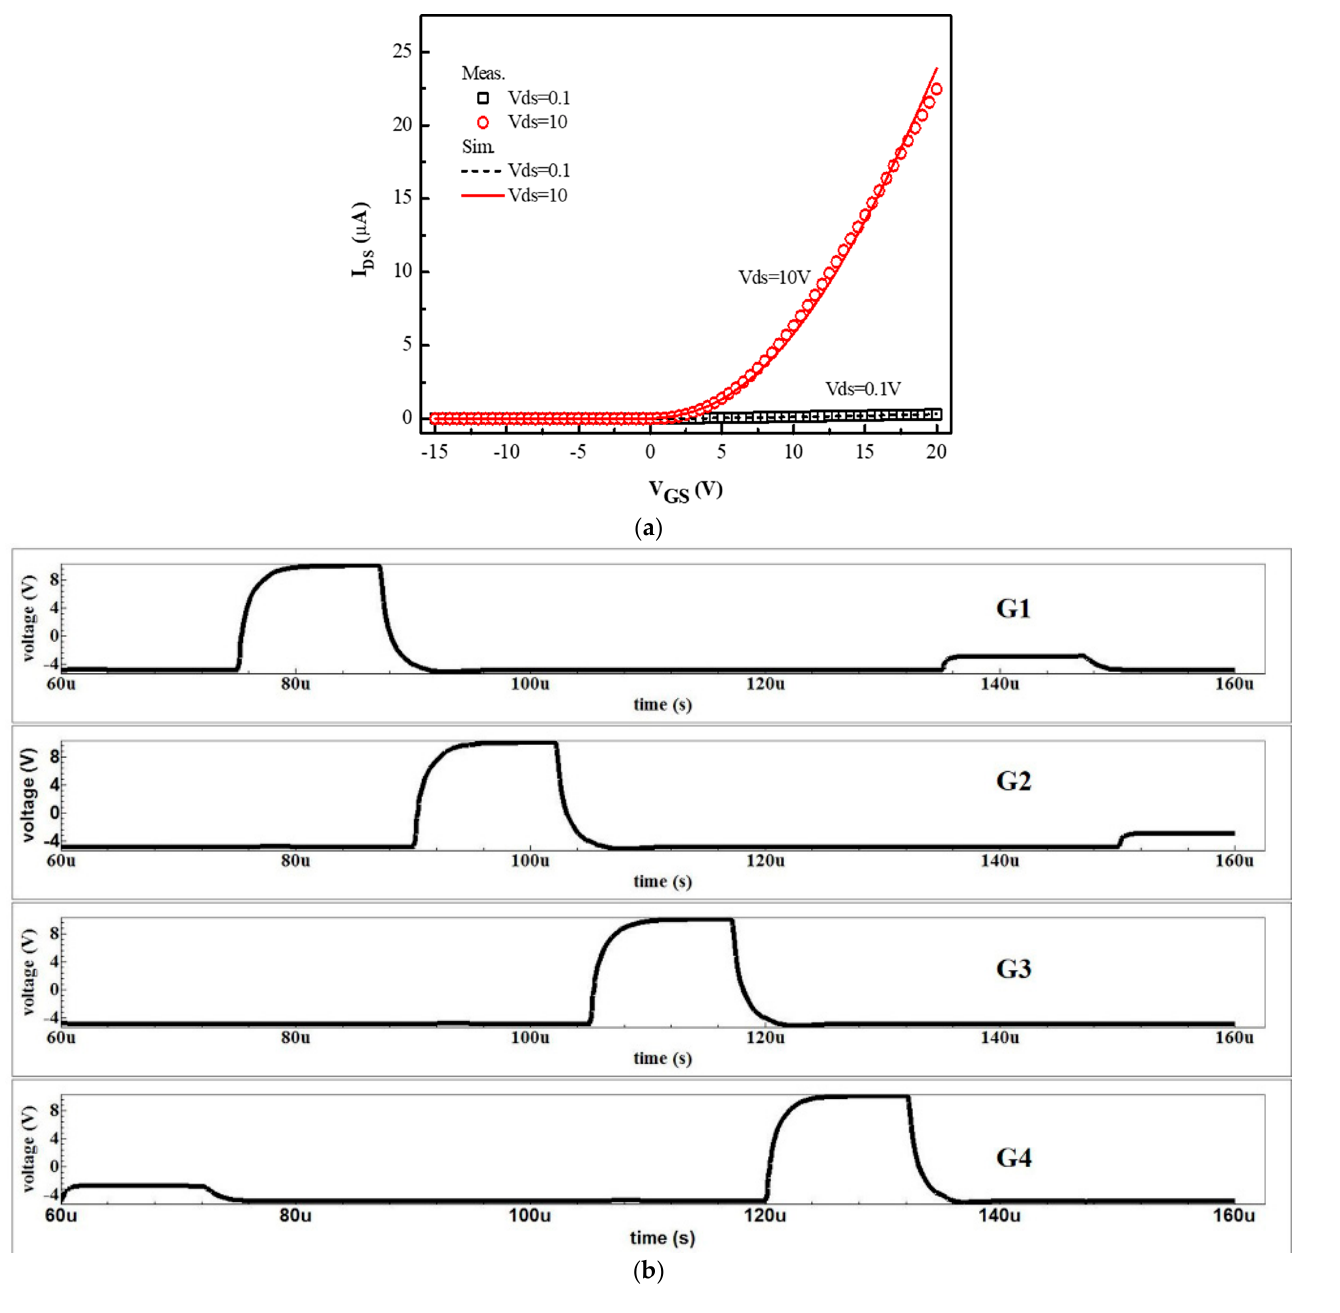
Figure 5. ( a ) The experimental result and device model of the transfer characteristics of IGZO-TFTs; ( b ) the output waveforms of the proposed SR circuits.